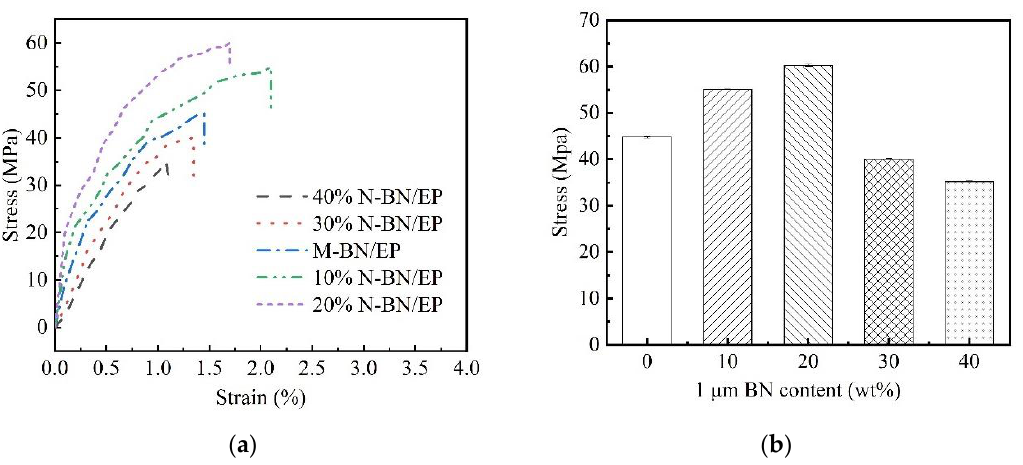
Figure 7. ( a ) Stress – strain curves of BN/EP composite and ( b ) Toughness of BN/EP composites.